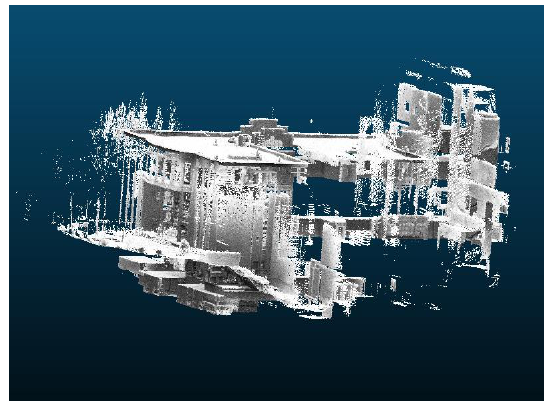
Figure 3. The collected SLAM-based point cloud from the College of Engineering, the University of Tehran.